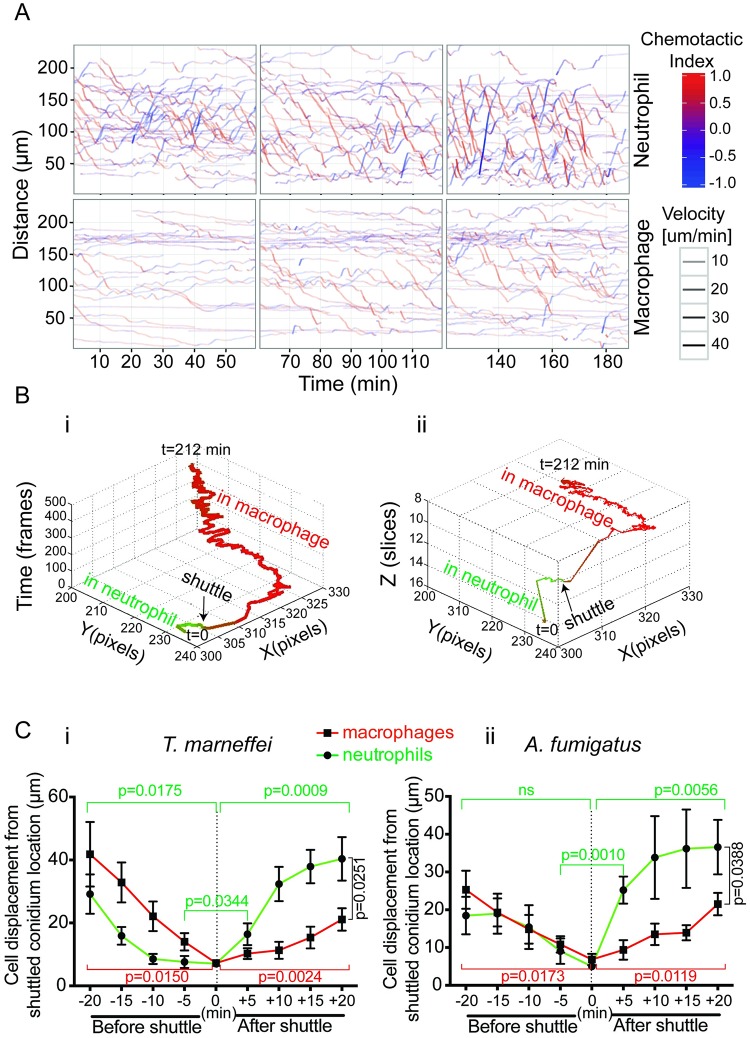
Phagocyte mobility during shuttling.(A) Cell tracking analysis of neutrophil and macrophage following intramuscular inoculation of T. marneffei conidia. A chemotactic index (red, movement towards infection; blue, movement away) and velocity (thickness of the line). Neutrophil migration towards the infection is earlier and faster; macrophage migration is later and slower. (B) Output of ShuttleFinder software for the shuttle shown in Fig 1A. Track color indicates the cellular context of the conidium (green, neutrophil; red, macrophage). (i) shows the shuttled spore track in xy dimensions and time. (ii) shows it in xyz dimensions. The two outputs collectively show that the shuttle occurred between donor and recipient phagocytes that were mobile in both space and time. Imaging parameters: x, y, 1.31 pixels/μm; z interval, 3.3 μm/slice; frame rate, 28.0 s/frame. (C) Plots of donor neutrophil and recipient macrophage cell displacement from the shuttle spore location over the 20-min period before and after the moment of shuttle for T. marneffei (i) and A. fumigatus (ii) shuttles. Note that displacement is a measured distance without directional information. Data are mean ± SEM at each time point (i, n = 10; ii, n = 7). P-values from two-tailed paired t tests (all +20 and -20 min vs 0 comparisons), otherwise from one-tailed paired t tests. Datasets for C are provided in S1 Data. ns, not significant.